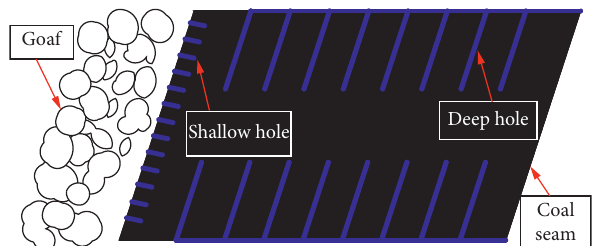
Figure 14: Layout of the deeply buried and shallow combined water injection boreholes in the examined coal